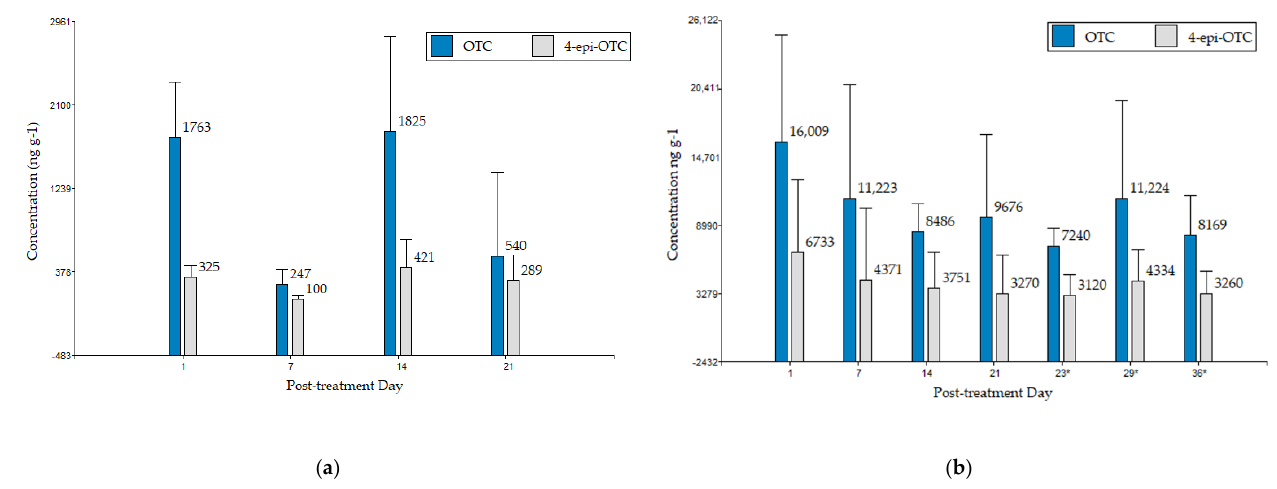
Figure 5. Concentrations of OTC and 4-epi-OTC in bird ( a ) droppings and ( b ) litter, from group A with 10% OTC, post the end of treatment and post slaughter (*: days post slaughter, correspond to 1-, 7- and 14-days post slaughter). Error bars represent the standard deviation.